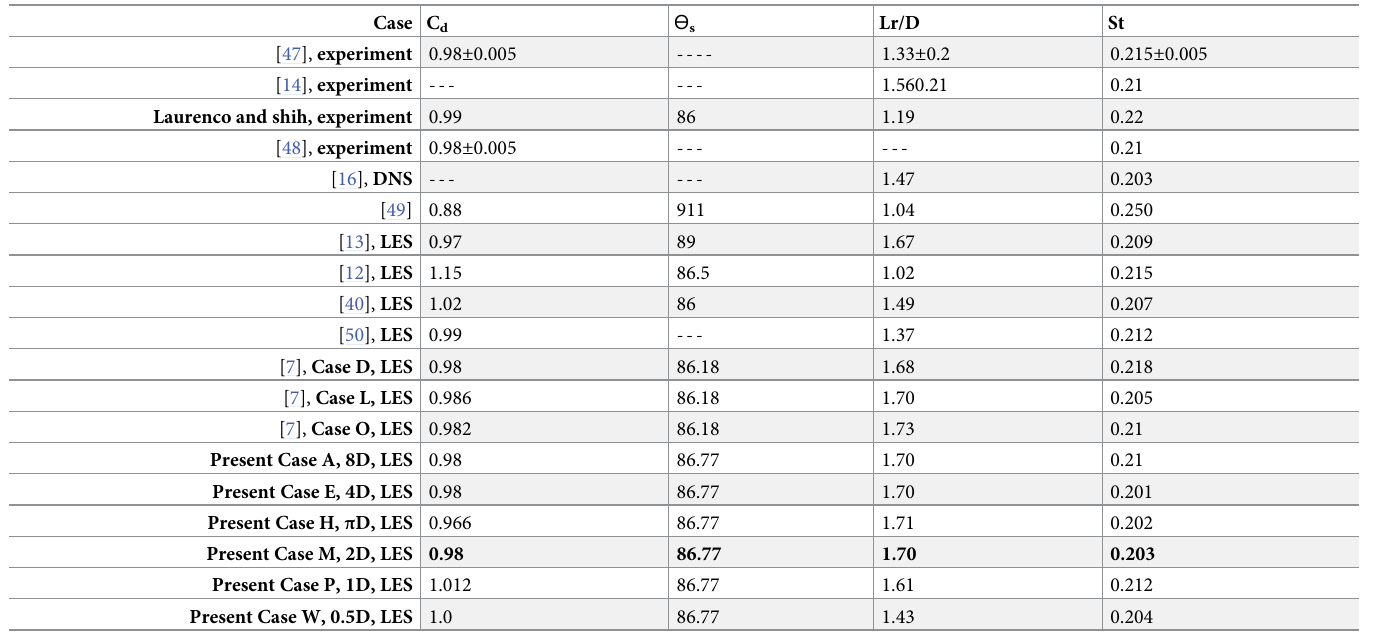
Table 3. At Re = 3900, comparison between numerical and experimental